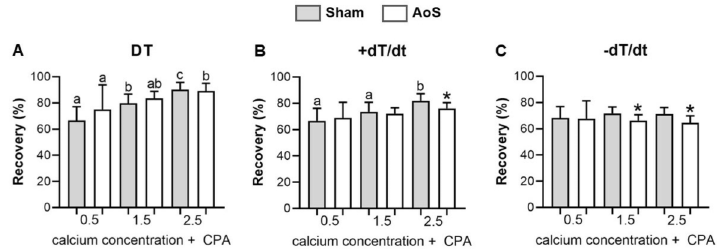
Figure 5. Function recovery in percentage post cyclopiazonic acid (CPA). DT: maximum developed tension; + dT/dt: maximum rate of tension development; – dT/dt: maximum rate of tension decline. Sham: animals submitted to simulated surgery (n=10); AoS: animals submitted to aortic stenosis surgery (n=10). Data are reported as means ± SD. *P o 0.05, AoS vs Sham (analysis of variance for repeated measures and Bonferroni post hoc test). Different letters indicate statistical difference among the moments within each